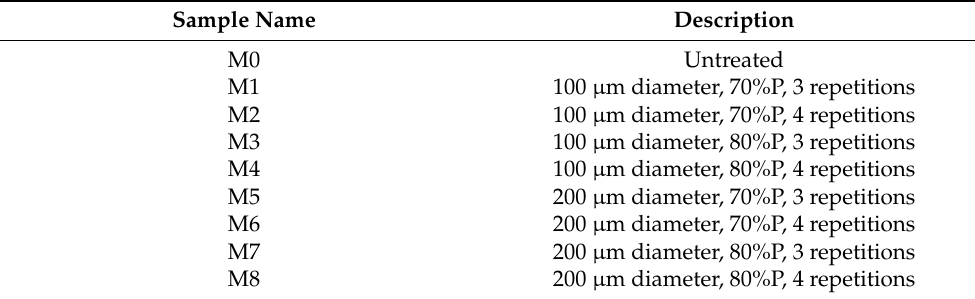
Table 5. Description of the employed samples.